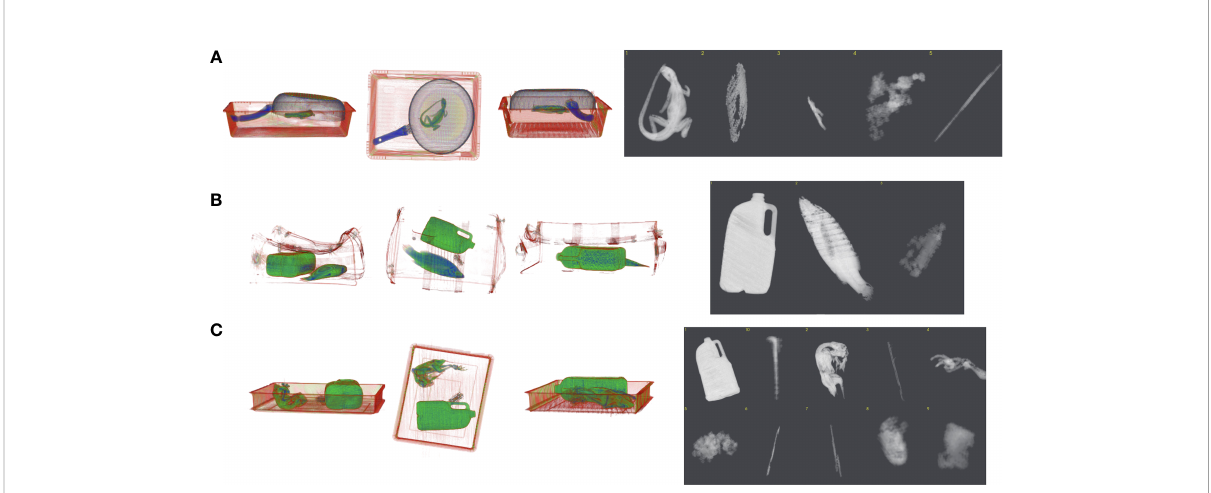
FIGURE 3 Example of segmentation using scanned CT images of wildlife for algorithm development to produce greyscale images. The colored 3D images are used for visualization only; image segmentations are calculated directly from the reconstructed radiodensity values in grayscale. (A) Australian water dragon ( Intellagama lesueurii ) under metal fry pan, (B) Barramundi fi sh ( Lates calcarifer ) in mock testing bag scenario with metal toy car, sock and water bottle, (C) Rainbow lorikeet parrot ( Trichoglossus moluccanus ) next to three litre water